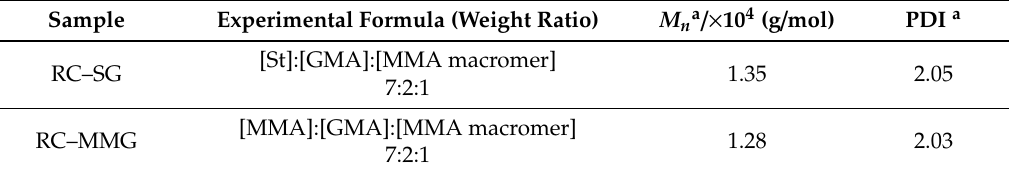
Table 1. Molecular characteristics of the reactive compatibilizers with various feed ratio.